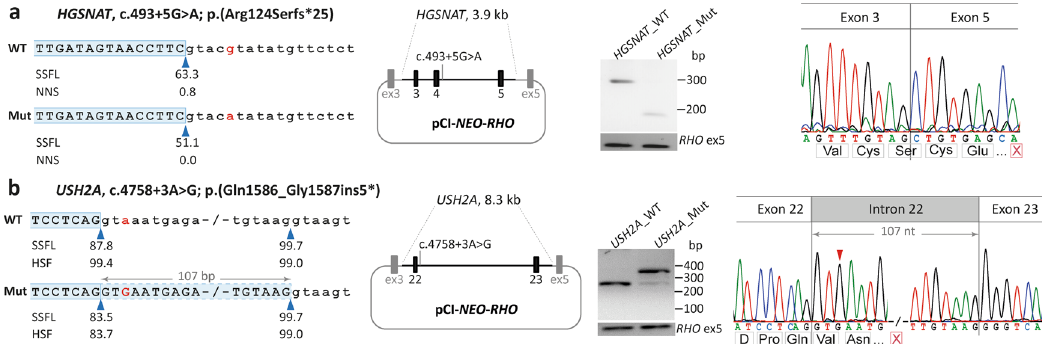
Fig. 2 Splice defects due to noncanonical splice site variants. For HGSNAT c.493 + 5G > A ( a ) and USH2A , c.4758 + 3A>G ( b ), the left panels are schematic representations of the gene segments of interest containing the corresponding variants in the wild-type (WT) and mutant (Mut) sequences. The SpliceSiteFinder ‐ like (SSFL, range 0 – 100), and Human Splicing Finder (HSF, range 0 – 100) or NNSPLICE (NNS, range 0 – 1) scores for the splice sites are indicated below each sequence. The blue triangles indicate the position of splice donor sites in both wild-type and mutant sequences. The red highlighted nucleotides indicate the variants in the mutant sequence. The second panels show the mutant pCI ‐ NEO ‐ RHO vectors. They contain the variants and fl anking exons 3, 4, and 5 in HGSNAT and exons 22 and 23 in USH2A fl anked by RHO exons 3 and 5. Wild-type and mutant constructs were used to transfect HEK293T cells. The next panels show the gel images of RT-PCR products in wild-type and mutant midigenes. RT ‐ PCR analysis of RHO exon 5 was performed as a control for transfection ef fi ciencies. In the last panels, the Sanger sequence analysis of the RT ‐ PCR fragments con fi rmed the exon 4 skipping in HGSNAT , c.493 + 5G>A ( a ) and 107-nt exon elongation in USH2A c.4758 + 3A>G ( b ). The red “ X ” in a red box indicates the stop codon in each schematic chromatogram. For each variant, both WT and mutant variants were examined in parallel in the same experiment and processed in